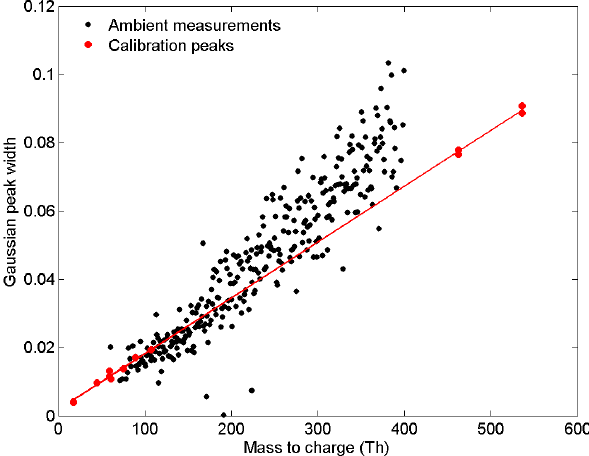
Fig. 4. Peak width dependency on m/Q . Black dots are peaks from ambient measurement and red dots are known pure substance peaks, all are fitted without constraining the peak width. Deviation of ambient measurements form the red line (linear fit to calibration peaks) indicates the presence of multiple overlying peaks at m/Q> 180Th.